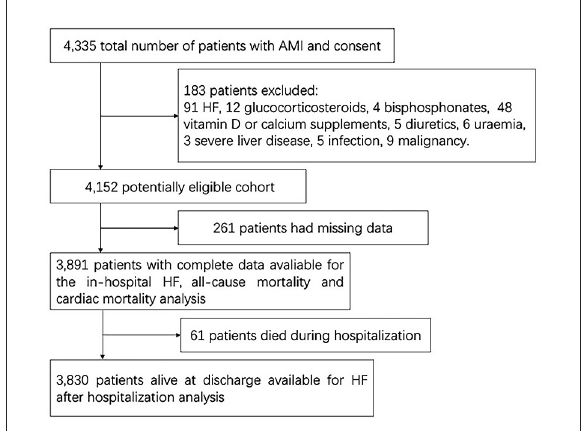
FIGURE1 Study sample. AMI, acute myocardial infarction; HF, heart